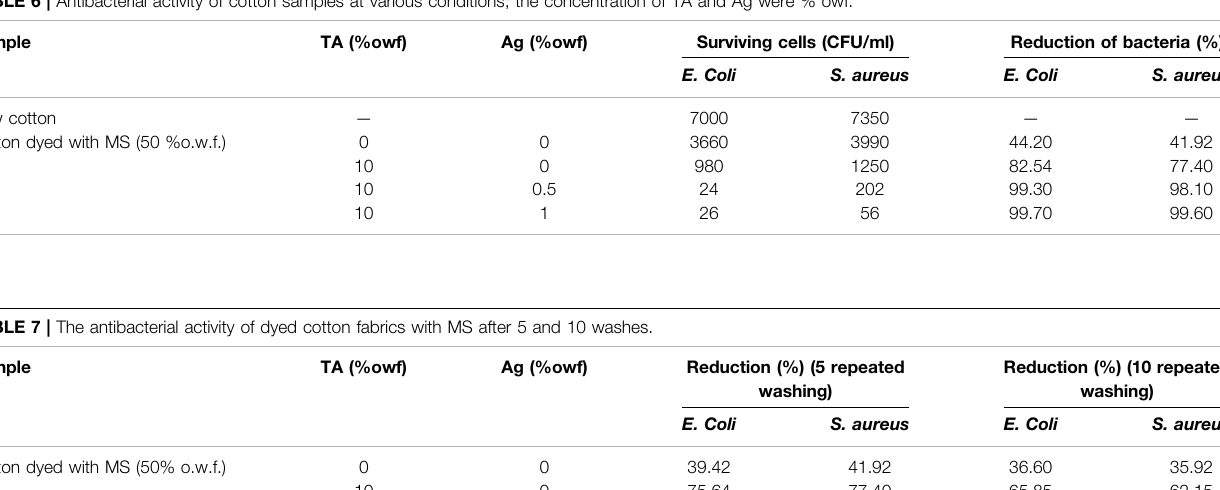
Cotton dyed with MS (50% o.w.f.)